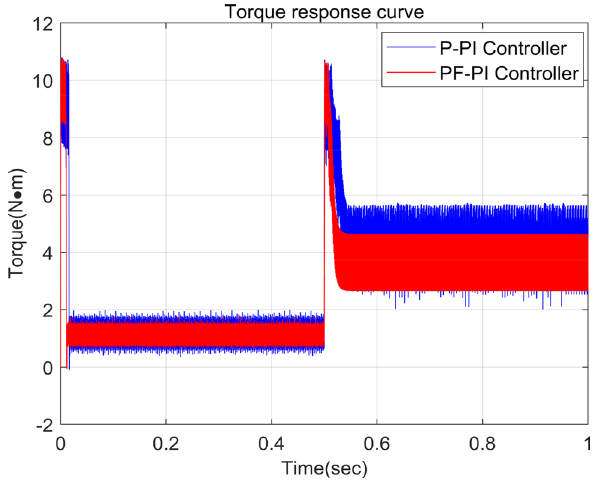
Fig. 14 Torque response curves of variable speed sudden addition disturbance load start under different conditions